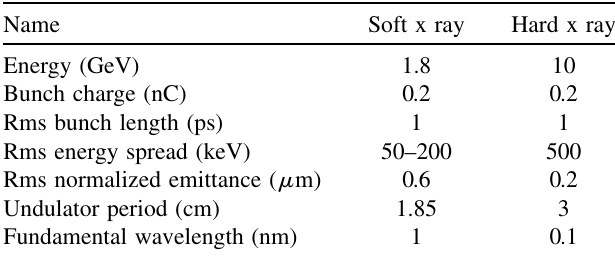
TABLE I. eRHIC beam parameters for FEL operation.